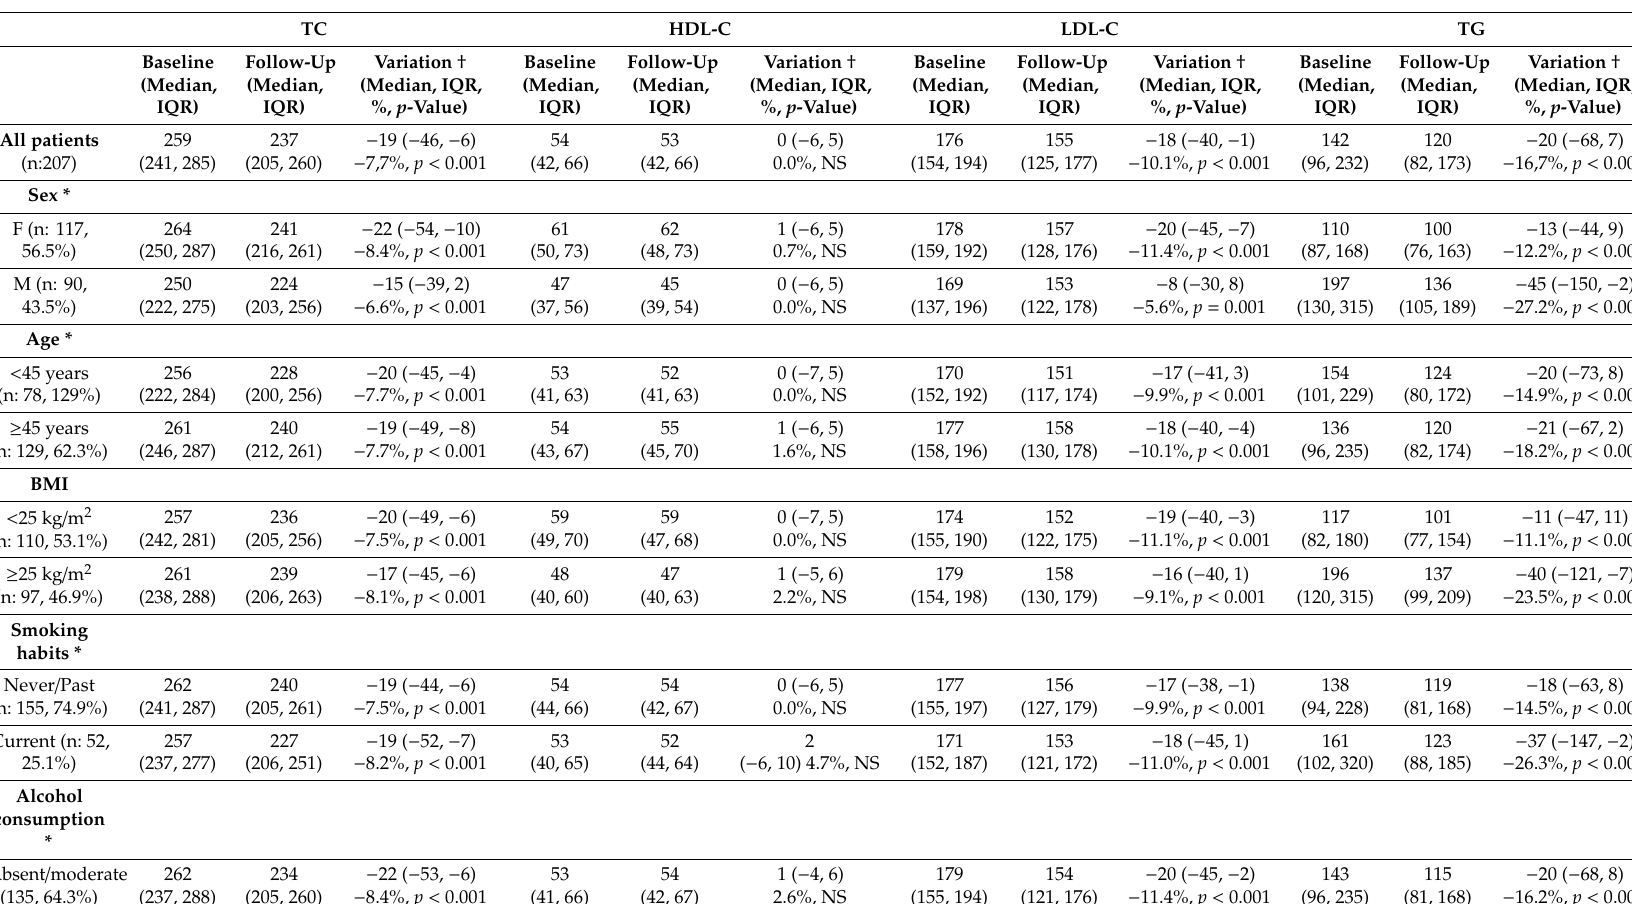
Table 2. E ff ect of diet alone on lipid profile overall and in specific groups of